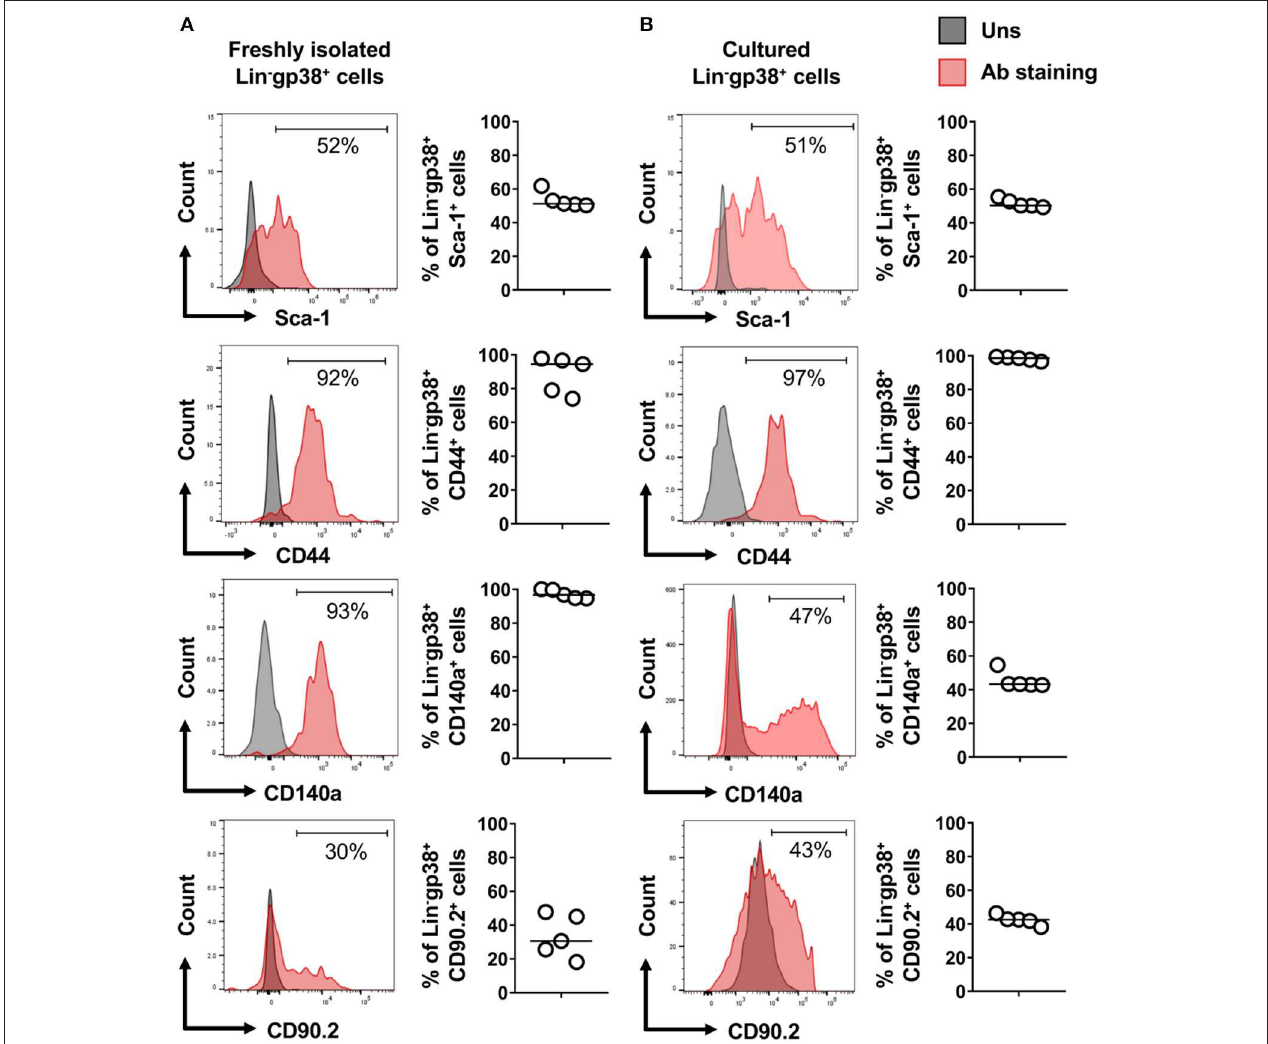
FIGURE 4 | Expression of mesenchymal cell markers on cardiac Lin − gp38 + cells. Representative flow cytometry histograms (data are representative for 1 out of 5 independent experiments; gray color indicates unstained controls) and quantification of the indicated mesenchymal markers on Lin − gp38 + cells of single cell suspension obtained from mouse heart (A) and cardiac Lin − gp38 + cells expanded in vitro for 3 passages (B) ( n =